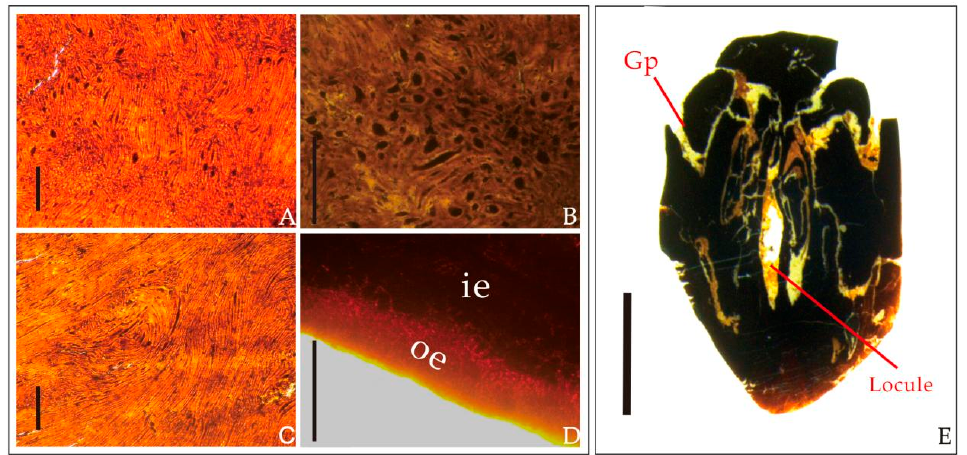
Figure 5. Internal structure and anatomical details of the Choerospondias tiantaiensis sp. nov. fossil endocarp (( A – E ), JHU3-16-059). ( A ): Fibers and sclereids of the endocarp wall, scale bar = 0.1